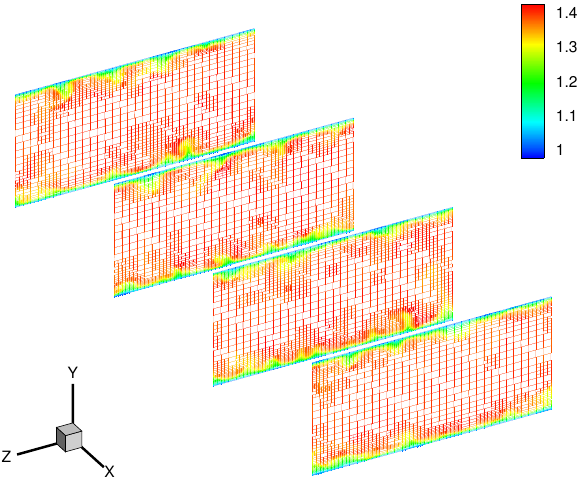
Figure 1. WA-LES of supersonic channel flow: instantaneous adapted mesh, colored by normalized temperature field, at four different channel